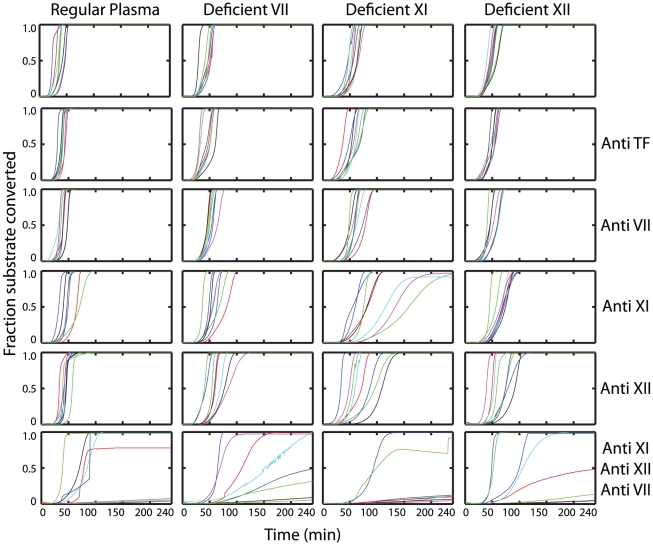
Prevention of initiation on CVX activated platelets.CTI-treated regular plasma or plasma deficient in factors VII, XI or XII were supplemented with washed (plasma free) platelets. These samples were left untreated or were treated with antibodies against TF; VII; XI; XII or XI, XII and VII simultaneously; and tested for thrombin generation without exogenous TF addition after activating platelets with 25 nM CVX. Simultaneous inhibition of XI, XII and VII activity was required to completely abolish thrombin generation.